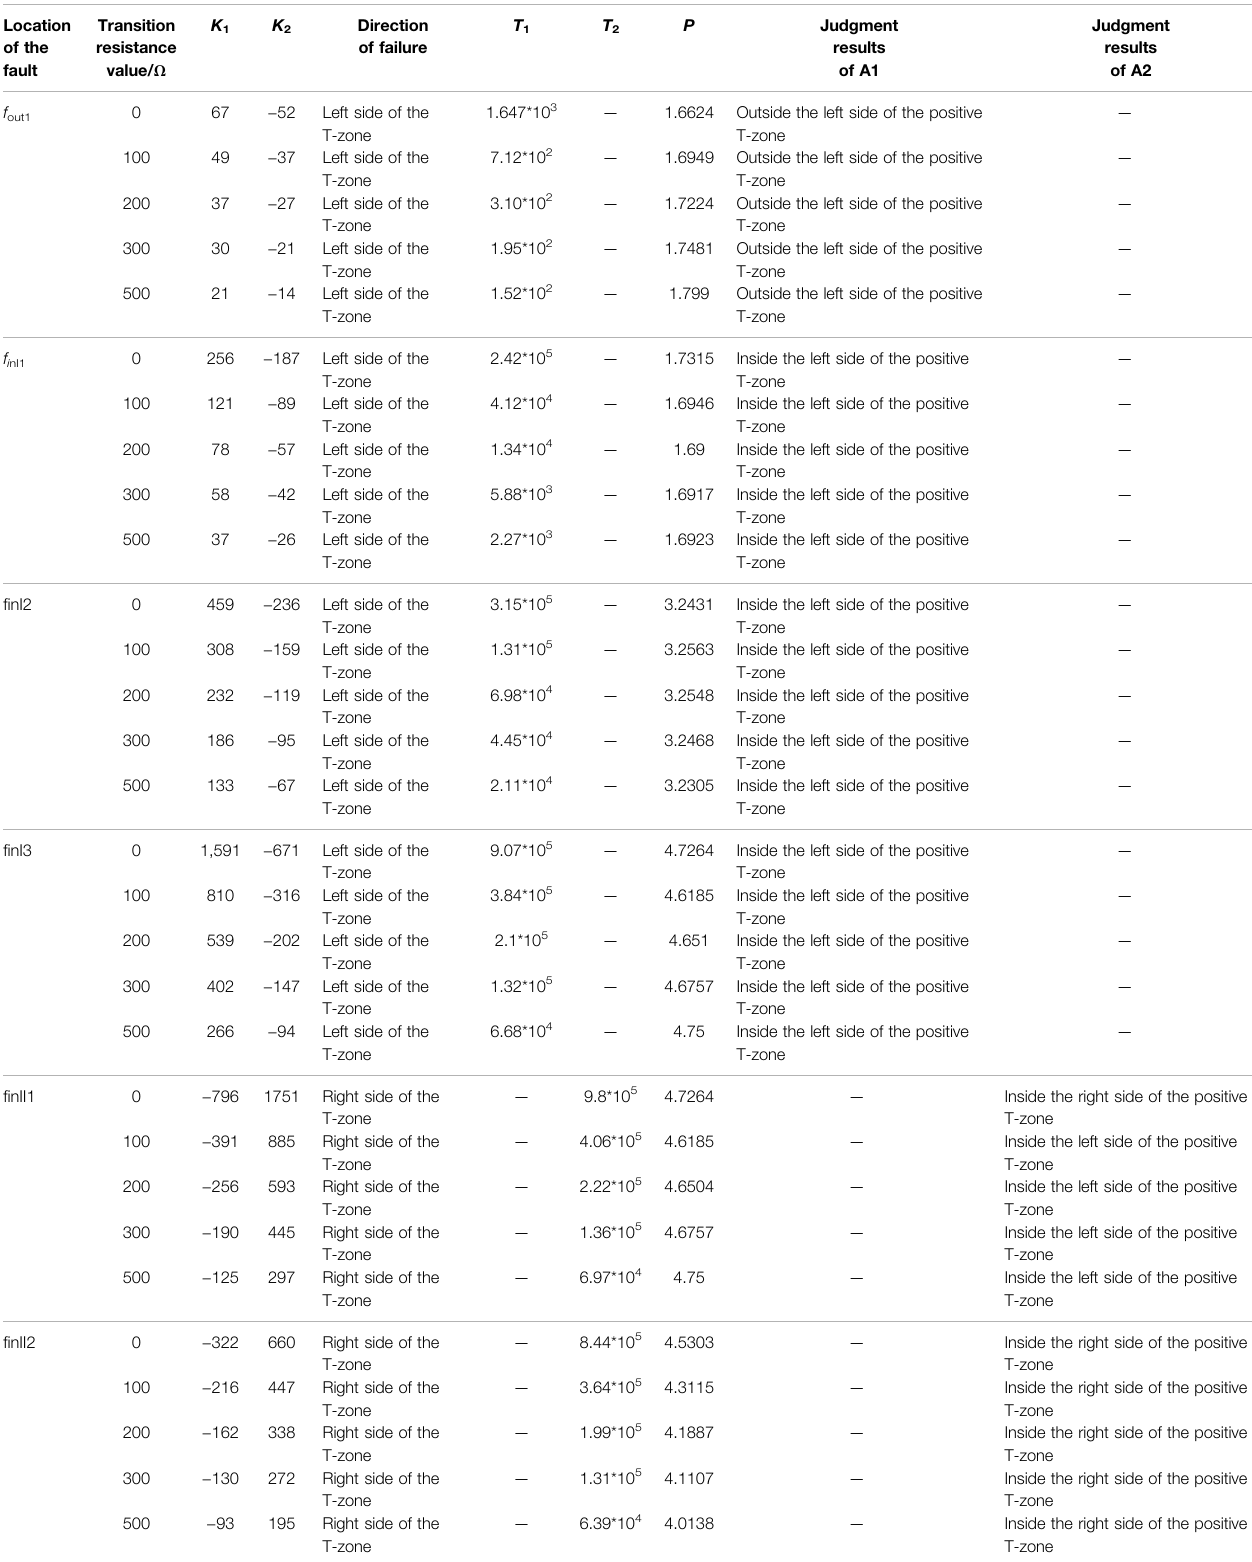
TABLE 2 | Simulation of the positive fault. Location of the